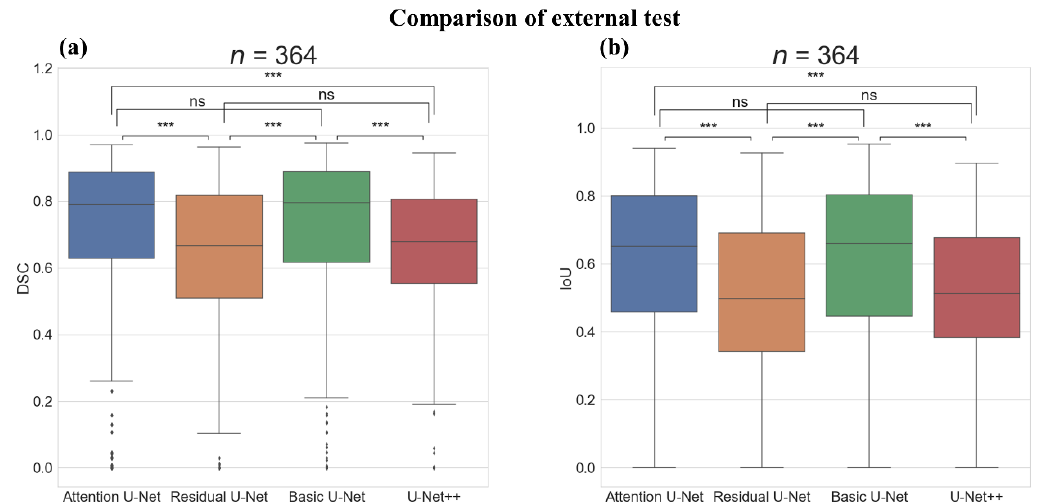
Figure 6. Comparison of external test with Boxplot representation and Wilcoxon test results between the deep-learning algorithms. ( a ) Boxplot representation and Wilcoxon test results of dice similarity score (DSC) and ( b ) Boxplot representation, and Wilcoxon test results of intersection over union score (IoU). ns: not significant, ***: p -value < 0.001, Number of images ( n ) = 364.